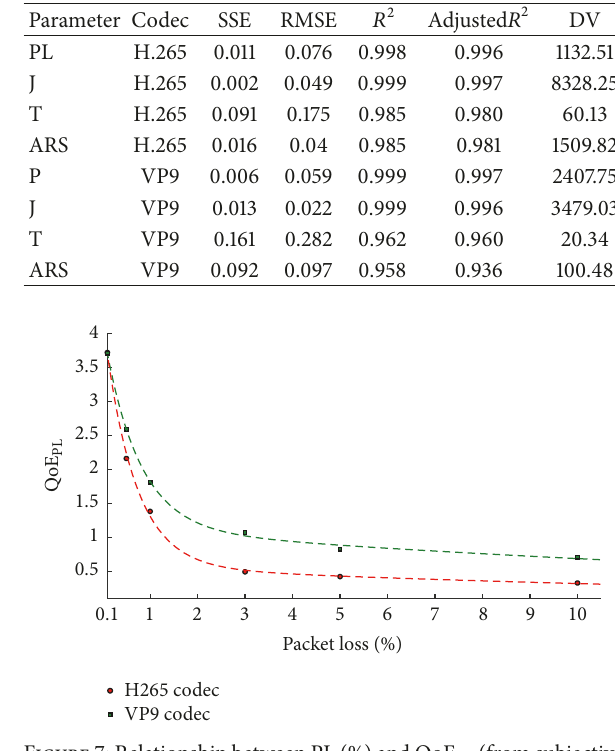
Figure 7: Relationship between PL (%) and QoE test).